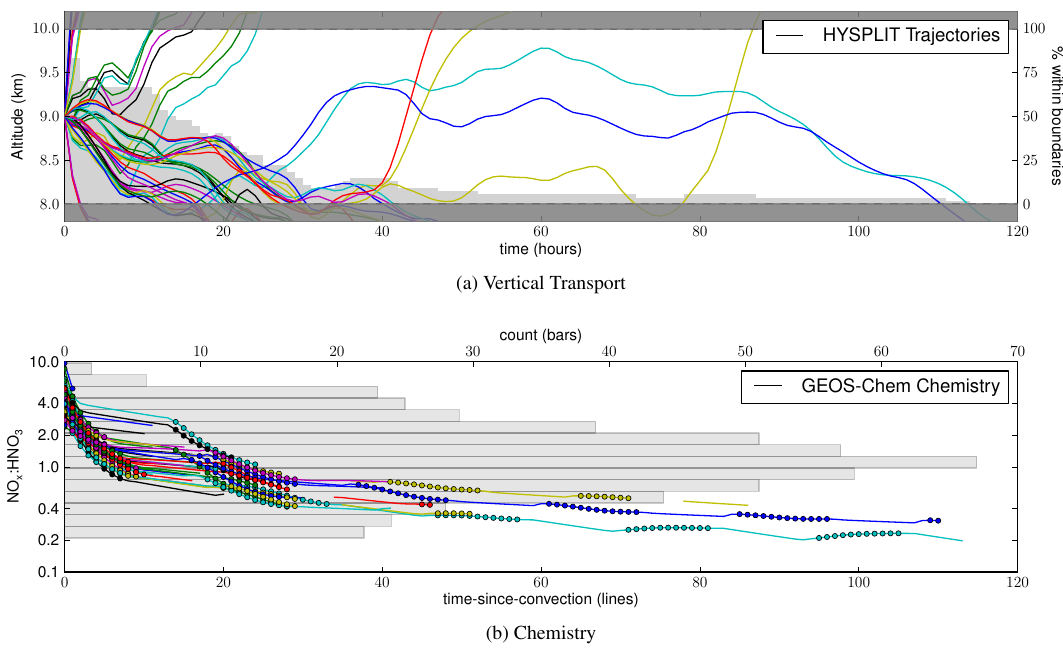
Fig. 1. Conceptual model of vertical transport (a) and chemistry (b) of hypothetical air parcels following convection. Vertical transport following convection is characterized in (a) by 54 lines from HYSPLIT trajectories that include convective motion and isentropic subsidence. During transport, NO x (and NO 2 ) is converted to HNO 3 by chemistry that is characterized by lines in (b) from GEOS-Chem simulations with night-time values in gray. Chemistry line segments are randomly paired with trajectories (by color) and hourly samples are included in the ensemble (represented by dots in b ). Ensemble members can only be selected during the day when observations were taken, and while within the 8 to 10 km study boundaries. The ensemble has a distribution of XNO 2 :HNO 3 (bars in b) that is approximately log-normal.